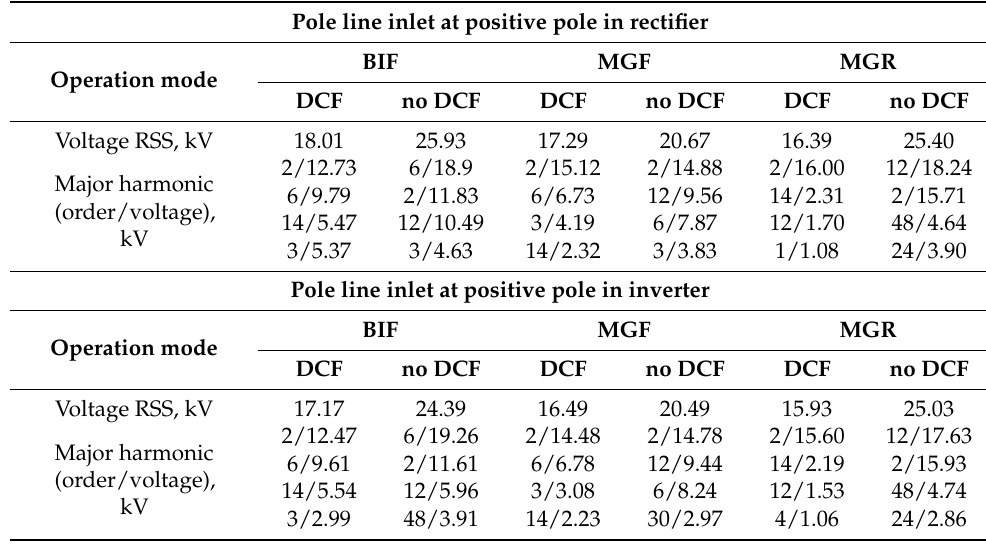
Table 7. Harmonic voltage stress at pole line inlet.